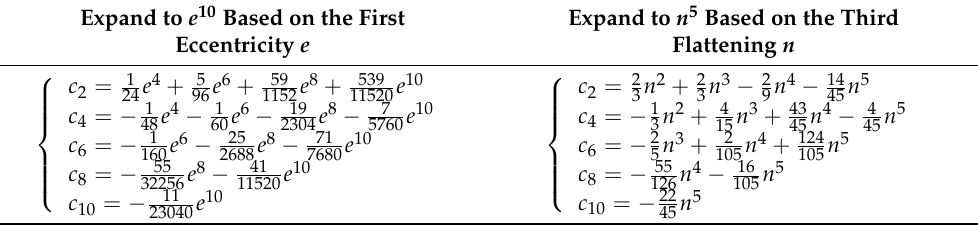
Table 8. Coefficients in Equation